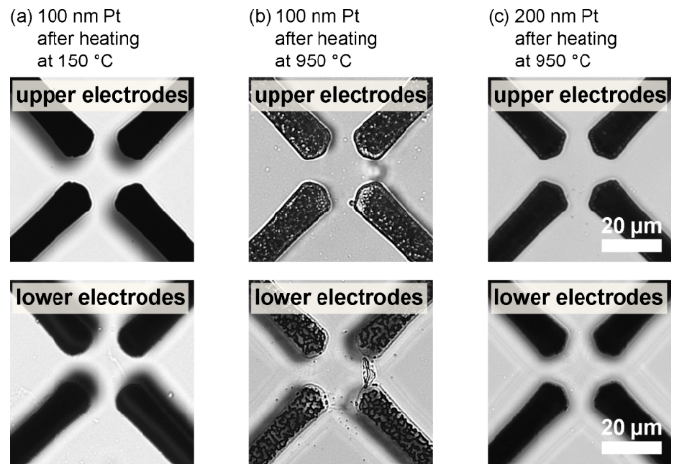
Figure 1. Microscopic images of upper and lower cage electrodes after thermal treatment: ( a ) 100 nm platinum layer after heating at 150 °C; ( b ) 100 nm platinum layer after heating at 950 °C; ( c ) 200 nm platinum layer after heating at 950 °C. Images were centered on the central point of the focused electrodes.